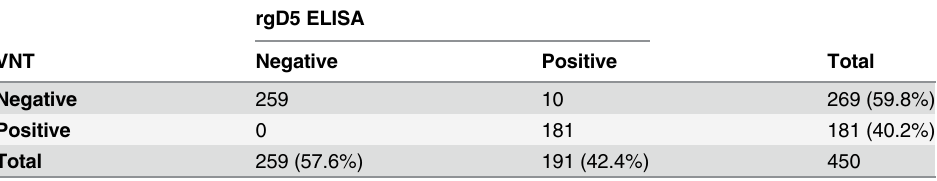
259 (57.6%) 191 (42.4%) 450 The table presents the results of 450 sera analyzed by VNT and